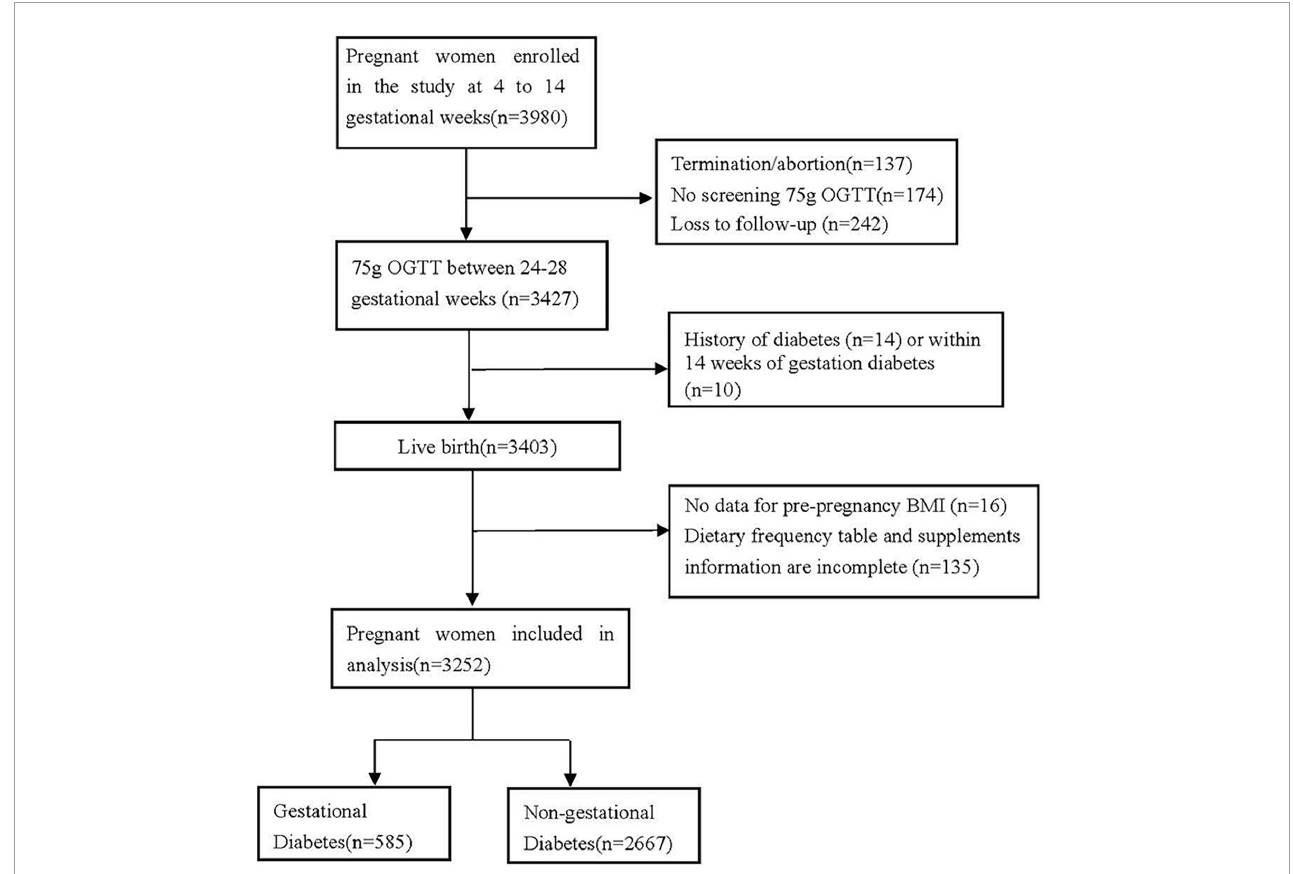
FIGURE1 Flow chart of the screening process for the selection of eligible